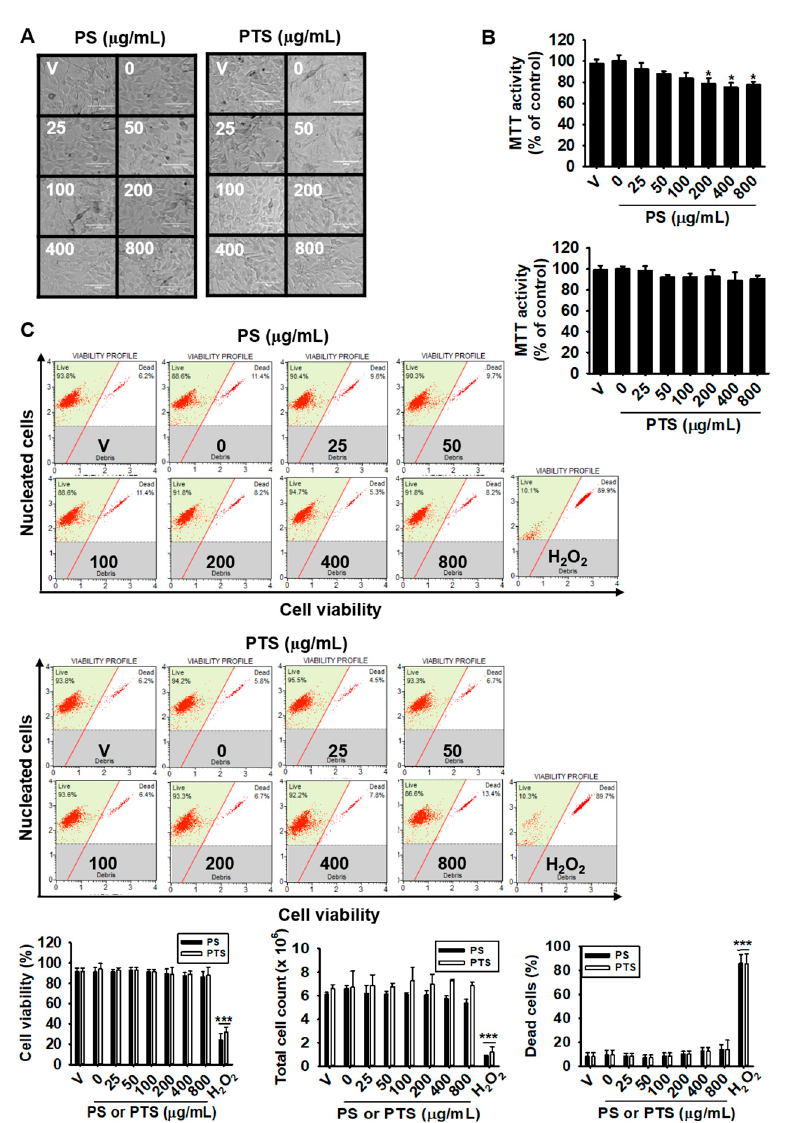
Figure 1. The Hibiscus syriacus L. varieties Pulsae and Paektanshim (PS and PTS) do not induce cytotoxicity in B16F10 cells. B16F10 cells were treated with 0–800 µ g / mL of PS or PTS for 72 h. ( A ) Microscopic images were captured and analyzed. All scale bars represent 100 µ m. ( B ) Mitochondrial activity was determined by the MTT assay. The activity in each group was presented as the percentage values of the untreated control. ( C ) In a parallel experiment, cell viability, total cell count and dead cell population were measured by flow cytometry analysis. H 2 O 2 (100 µ M) was used as a positive control for cell death. Data are reported as the mean ± SEM of three independent experiments ( n = 3). * p < 0.05 and *** p < 0.001, vs . untreated group. V; vehicle (0.05% DMSO).